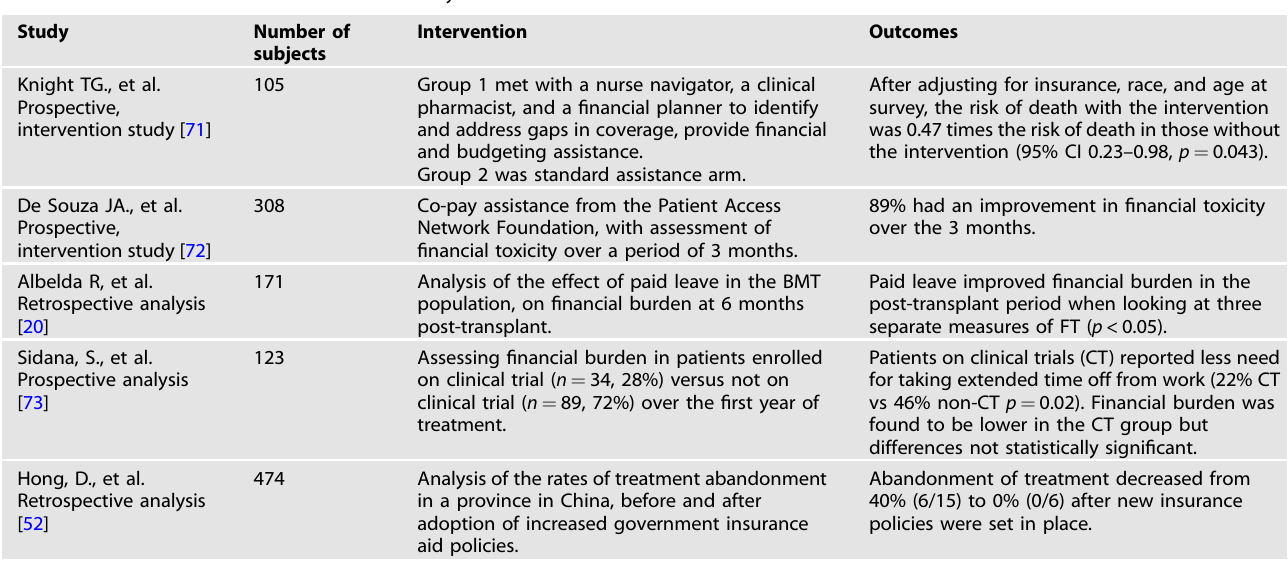
Table 5. Interventions to alleviate fi nancial toxicity.